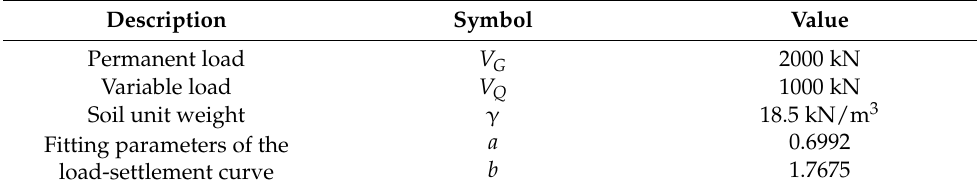
Table 10. The characteristics of the deterministic variables used in foundation optimisation. Description Symbol Value Permanent load V G 2000 kN Variable